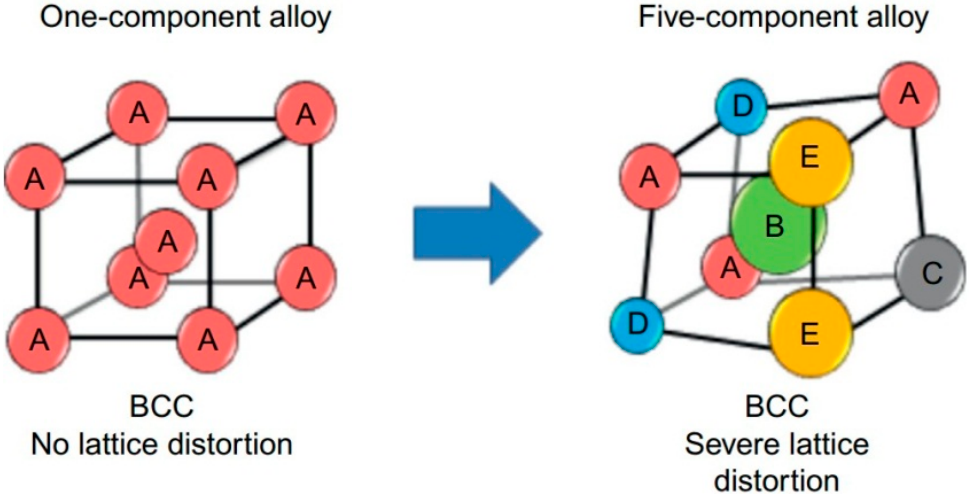
Figure 2. Schematic illustration of lattice distortion.